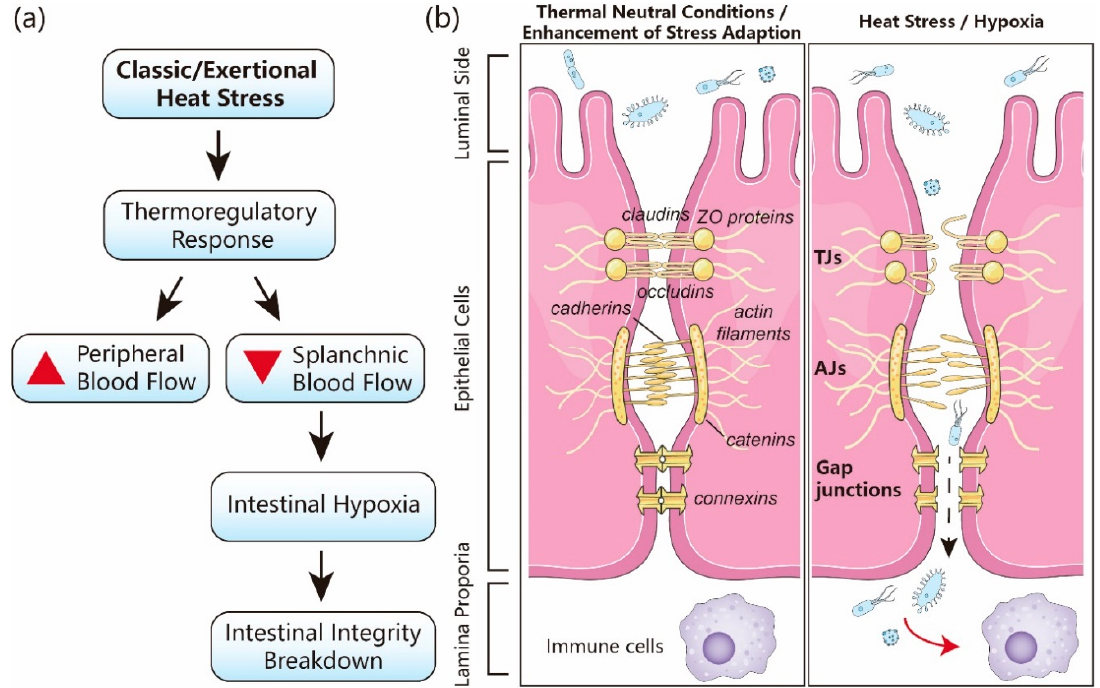
Figure 1. The sequence of events leading to heat stress-induced intestinal barrier damage. Hyperthermia induced by environmental or exertional heat stress (HS) stimulates the thermoregulatory mechanisms. ( a ) In the whole body, the thermoregulatory response shifts the splanchnic blood flow to the peripheral blood circulation, resulting in hypoxia in intestines and intestinal barrier dysfunction. ( b ) At the cellular level, hyperthermia leads to disruption of intestinal epithelial integrity, mainly by affecting the tight junctions (TJs) and adherens junctions (AJs), which are responsible for sealing the paracellular space between adjacent cells. Damage to TJs and AJs facilitates the transfer of luminal toxins and pathogens (light blue bodies) through the epithelial barrier into the lamina propria, harboring numerous immune cells that are activated and contribute to the exaggeration of the inflammatory reactions, which may further worsen the intestinal damage. ZO: zonula occludens protein.